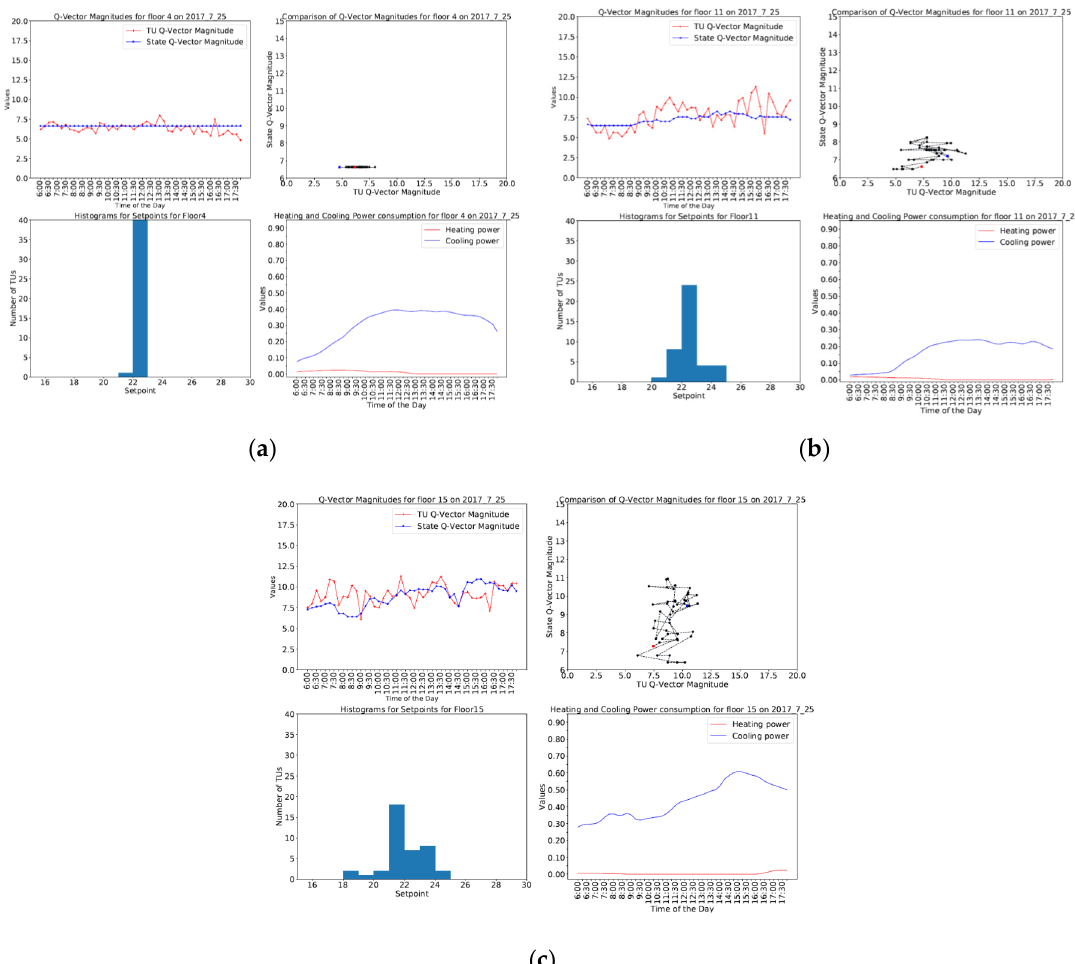
Figure 11. Graphs depicting the variation of TU Q-vector magnitudes and state Q-vector magnitudes, Scatterplot of TU and state Q-vector magnitudes, Set point histogram, Heating and cooling power consumption for different behaviors on ( a ) Floor 4 ( b ) Floor 11 ( c ) Floor 15 on 2017.7.25 (summer day).